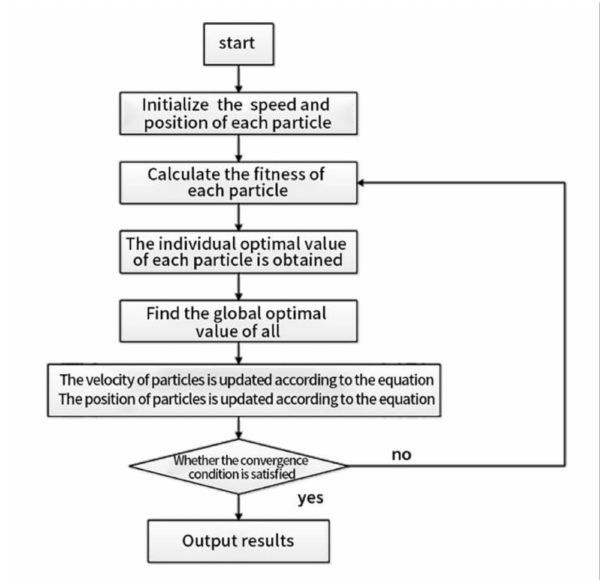
Figure 5. Flow chart of the standard particle swarm optimization (PSO)